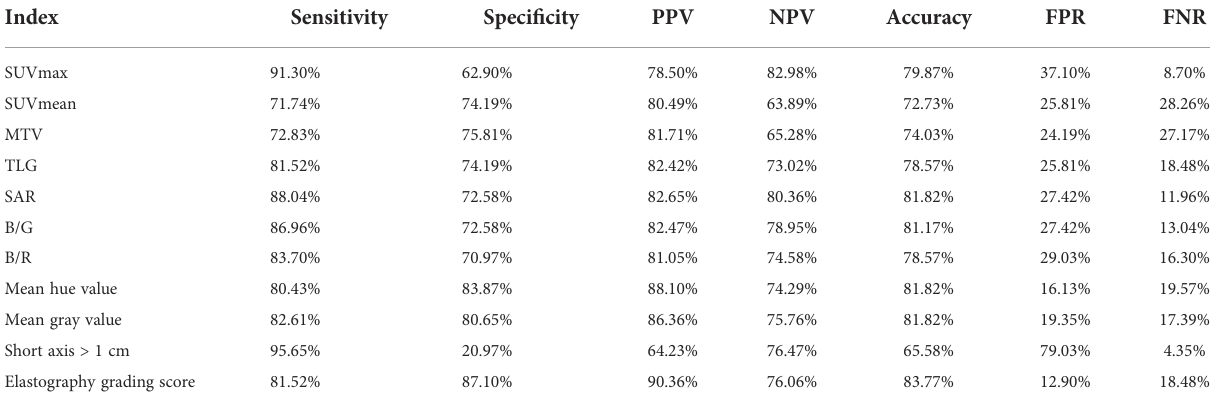
TABLE 4 Diagnostic ef fi ciency of PET/CT and elastography variables for malignant lymph nodes prediction in the model